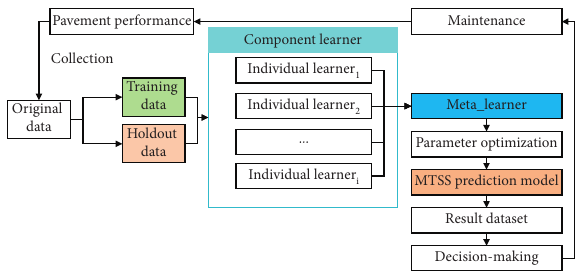
Figure 3: The digital twin learning